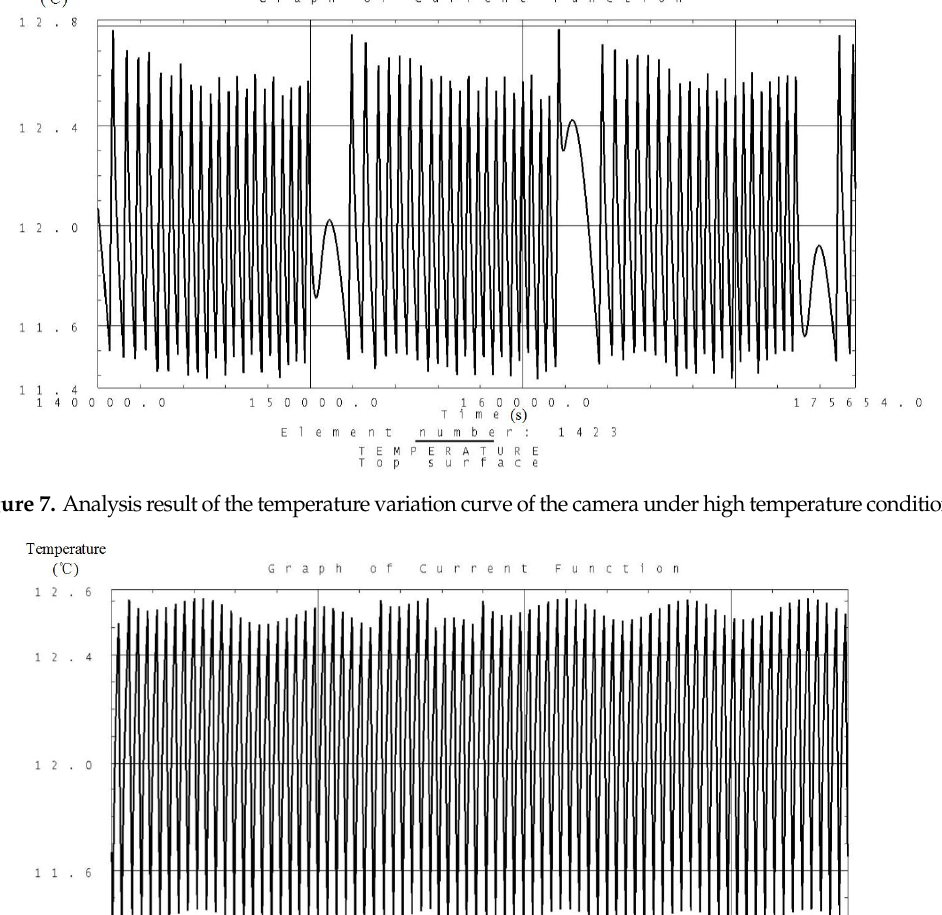
Figure 8. Analysis result of the temperature variation curve of the camera under low temperature conditions.